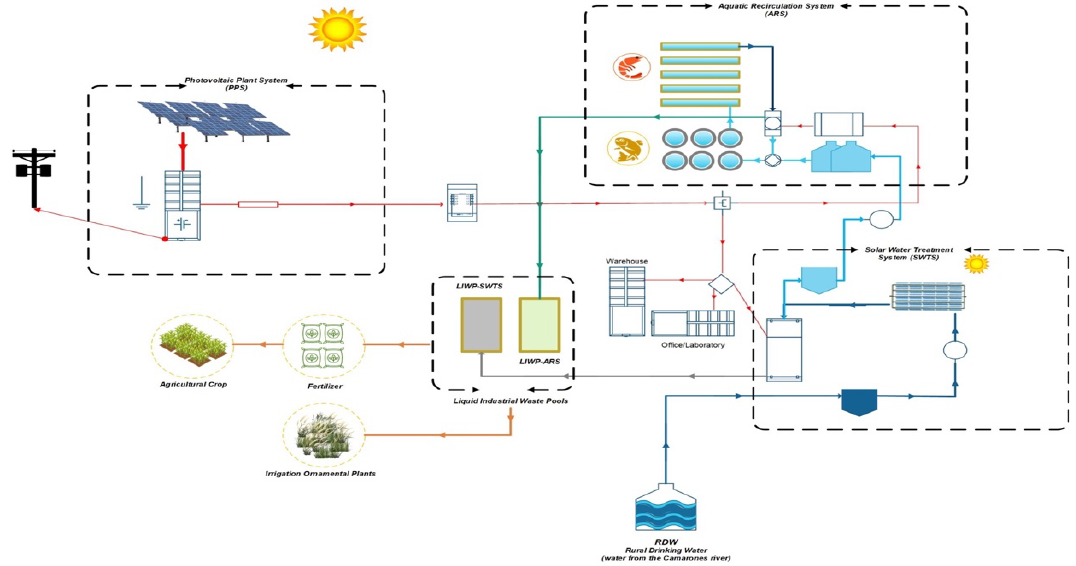
Figure 6. Integrated aquatic recirculation system plant system (proper elaboration).